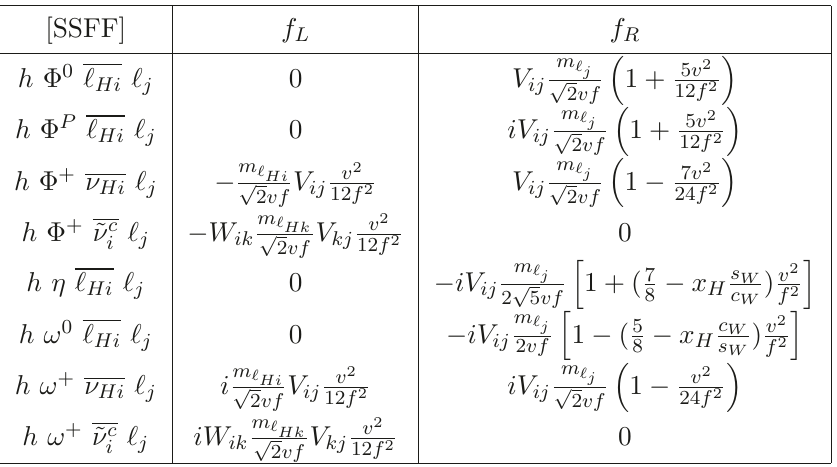
2 ( v ). The coupling hφ ++ ˜ ℓ c f 2 O